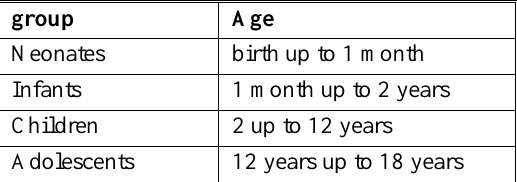
Table 2. Age groups as suggested by FDA (10) . group Age Neonates